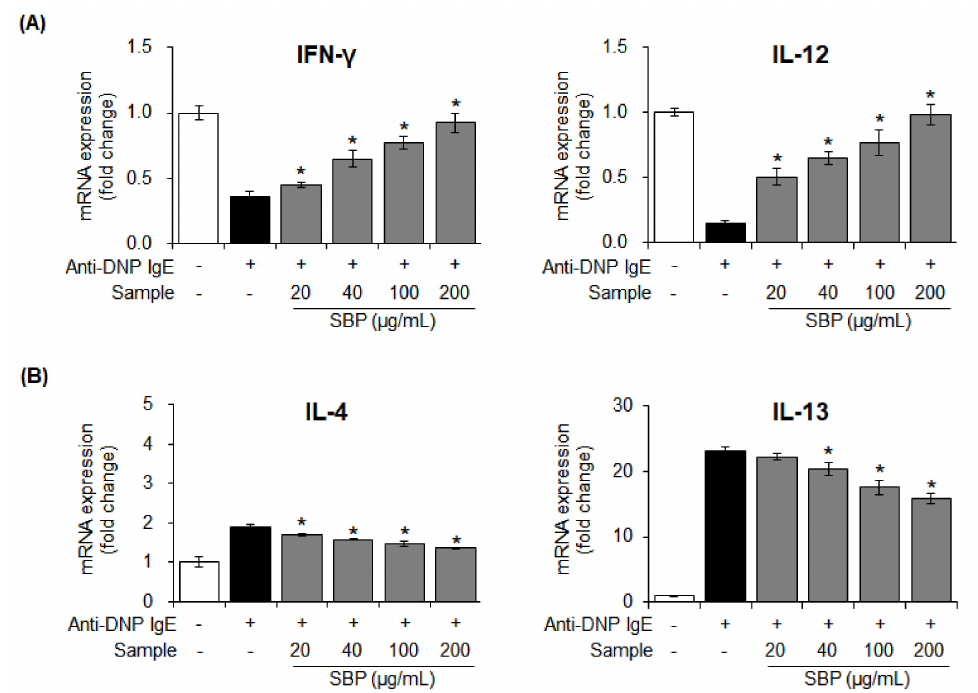
Figure 6. Effects of the SBP extract on mRNA expression of pro − ( B ) and anti − inflammatory ( A ) cytokine in RBL − 2H3 cells. Data are expressed as mean ± SEM. Significantly different from the LPS − treated group (* p < 0.05). SBP, sword bean pod; IFN- γ , interferon gamma; Il-12, interleukin-12; IL-4, interleukin-4; IL-13,